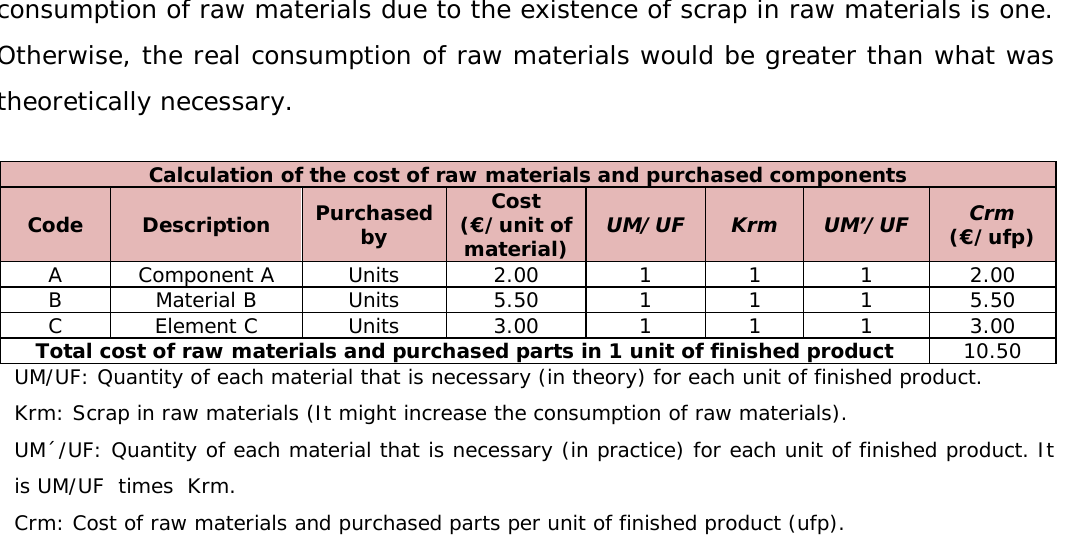
Table 7. “Cost of materials and